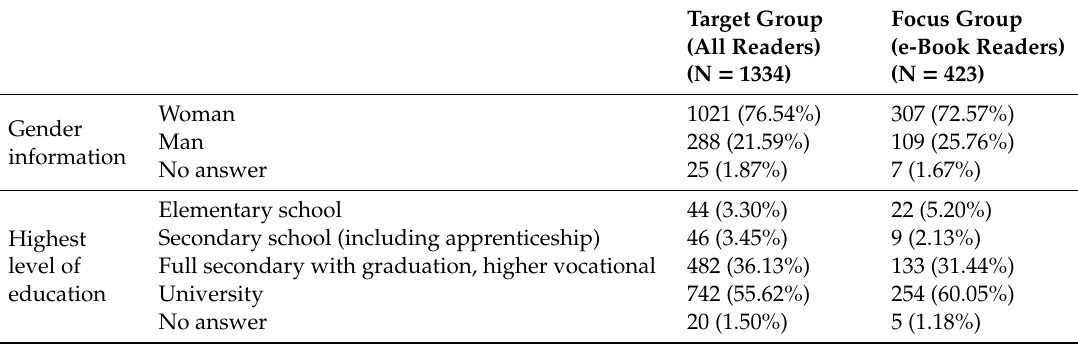
Table 1. Socio-economic information about the research